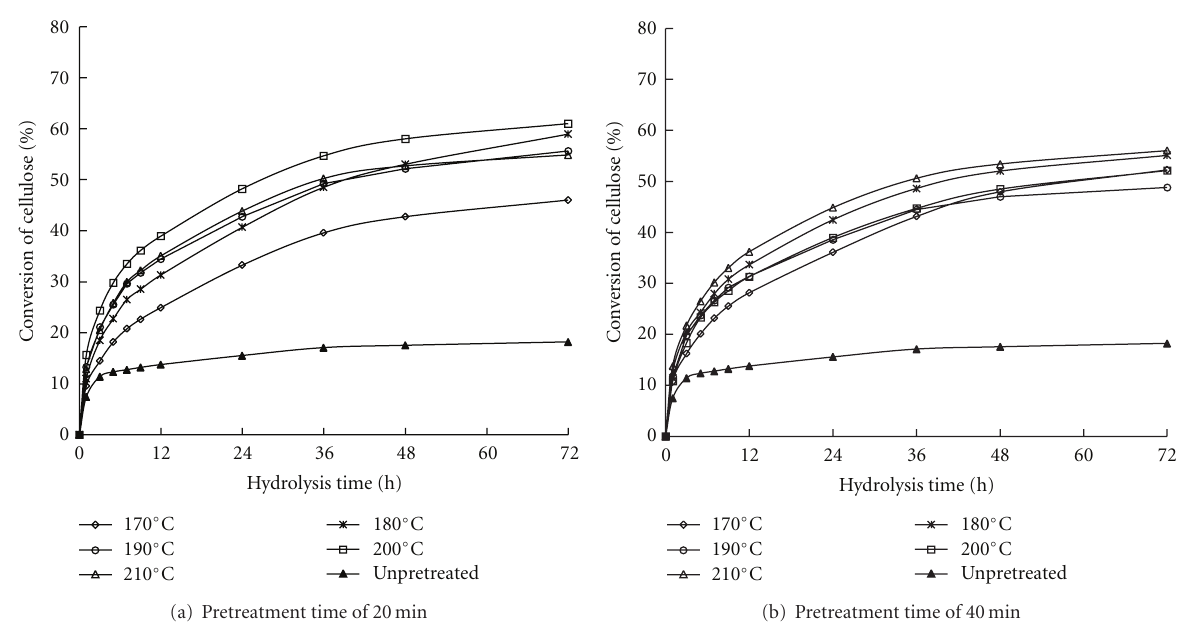
Figure 1: Conversion of cellulose to glucose in the enzymatic hydrolysis of WIS from LHW-pretreated reed, with di ff erent pretreatment temperatures and times. ∗ Enzymatic hydrolysis conditions: 15 FPU/g oven-dried WIS, pH 4.8, solid-to-liquid ratio 1:50 (w/v), and 50 ◦ C for 72 h.